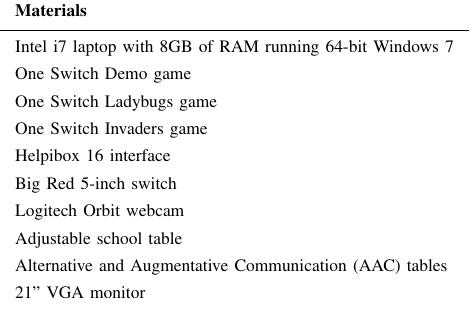
TABLE I. M ATERIALES USED FOR CARRYING OUT THE TESTS